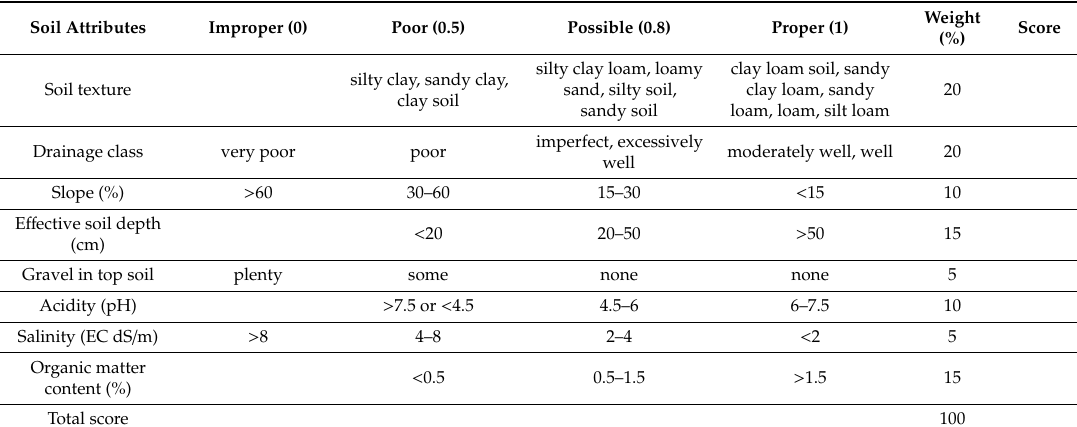
Table 2. The suitability criteria of sorghum–sudangrass hybrid to soil